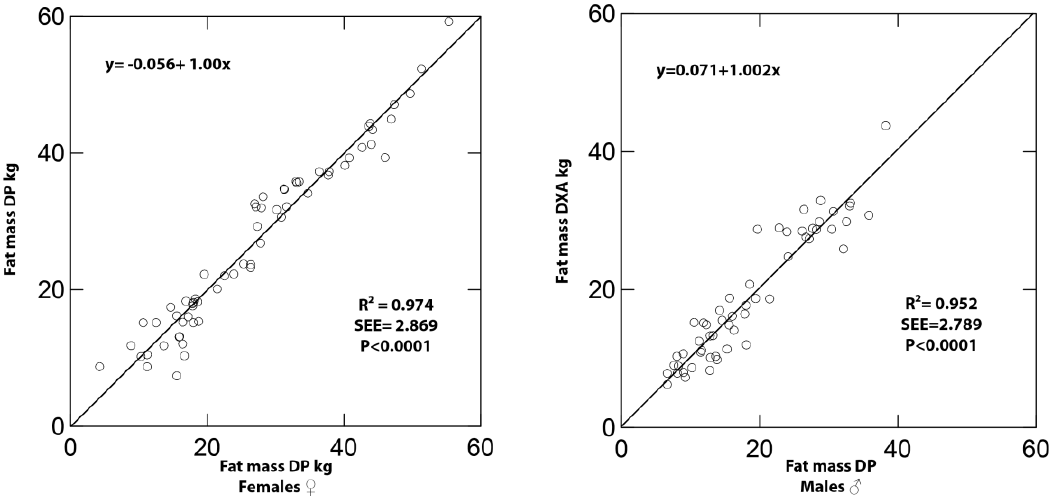
Figure 2. Plots of dual X-ray absorptiometry (DXA)-measured and digital image photography (DP)-predicted fat mass (FM) values of females ( left ) and males ( right ).